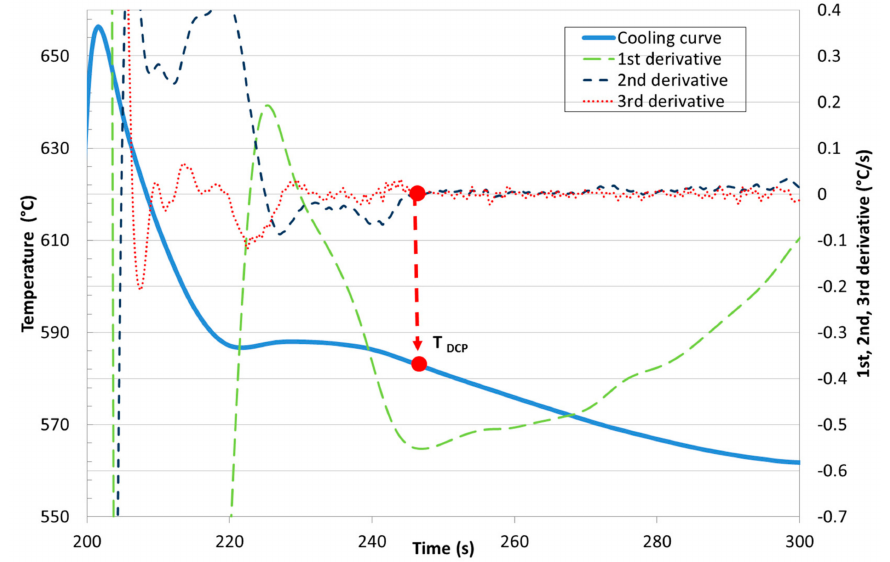
Figure 5. Method 5: the DCP determination at the crossing point of the second and third derivative of dT/dt vs.